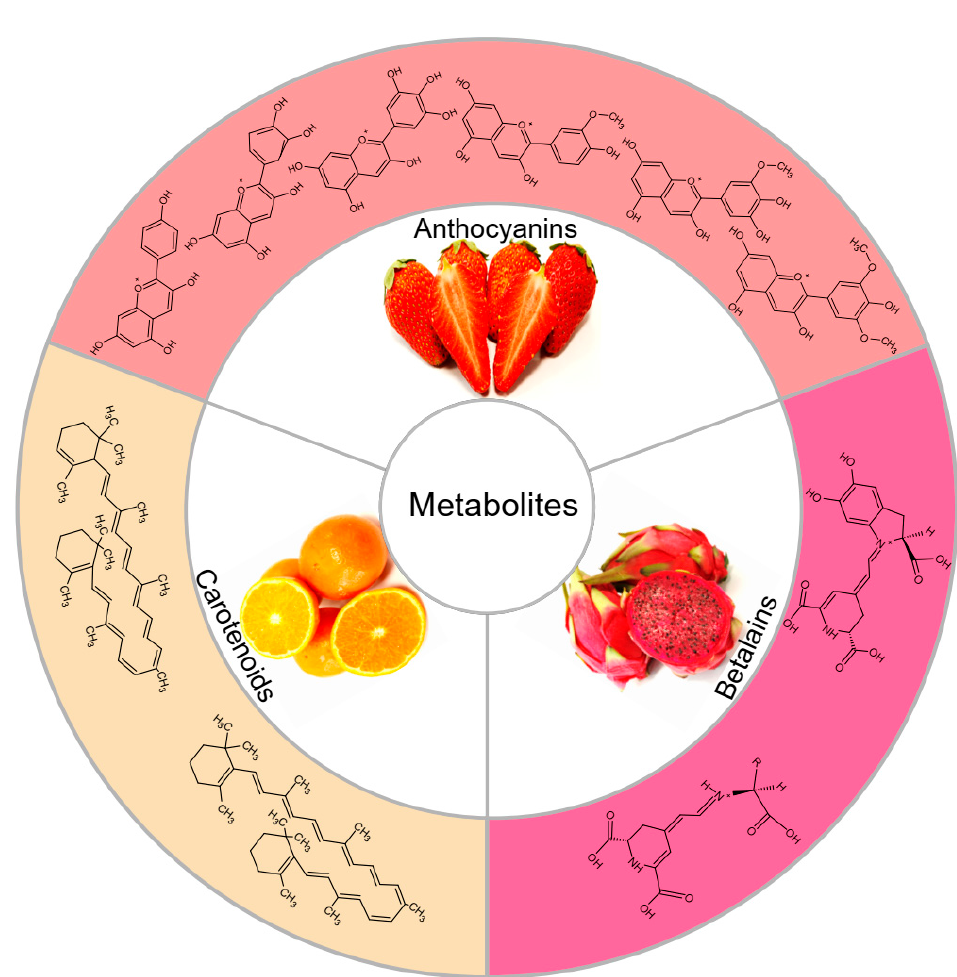
Figure 1. Dietary sources of plant pigments. Strawberry , Citrus sinensis , and Pitaya . Chemical struc- tures of anthocyanins, α -Carotene, β -Carotene, betaxanthin, and betacyanin.